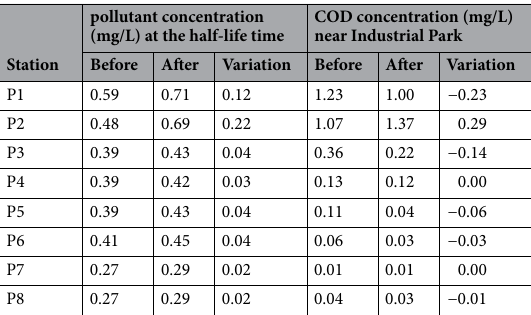
pollutant concentration (mg/L) at the half-life time Station Before After Variation Before After